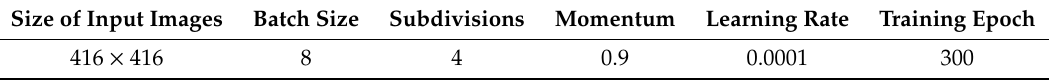
Table 1. Initialization parameters.